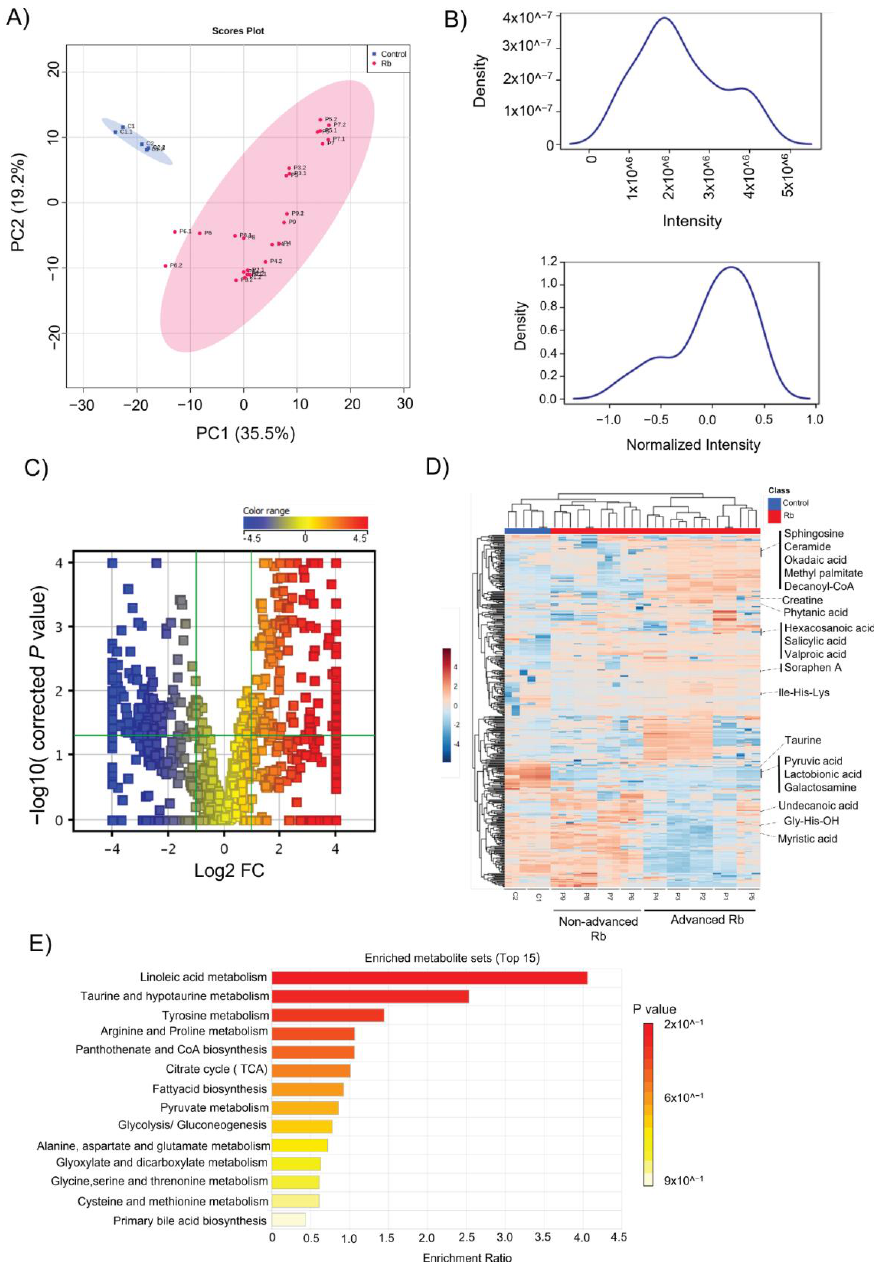
Figure 4. Differentially accumulated metabolites revealed the enrichment of key metabolic pathways in Rb vitreous humor. ( A ) Principal component analysis of metabolite profiling in the vitreous humor of Rb and pediatric controls. ( B ) Density plot showing the distribution of metabolite intensity before and after normalization. ( C ) Volcano plot of differentially accumulated metabolites. p < 0.05 (in red), FC > 2: significantly increased; p < 0.05, FC < 2 (in blue): significantly reduced relative to the control. ( D ) Hierarchical clustering heatmap of significant metabolites in the vitreous humor of Rb and controls using Pearson correlation as the metric distance. The color code indicates the metabo- lite’s abundance. ( E ) KEGG pathway enrichment analysis of differentially accumulated metabolites.